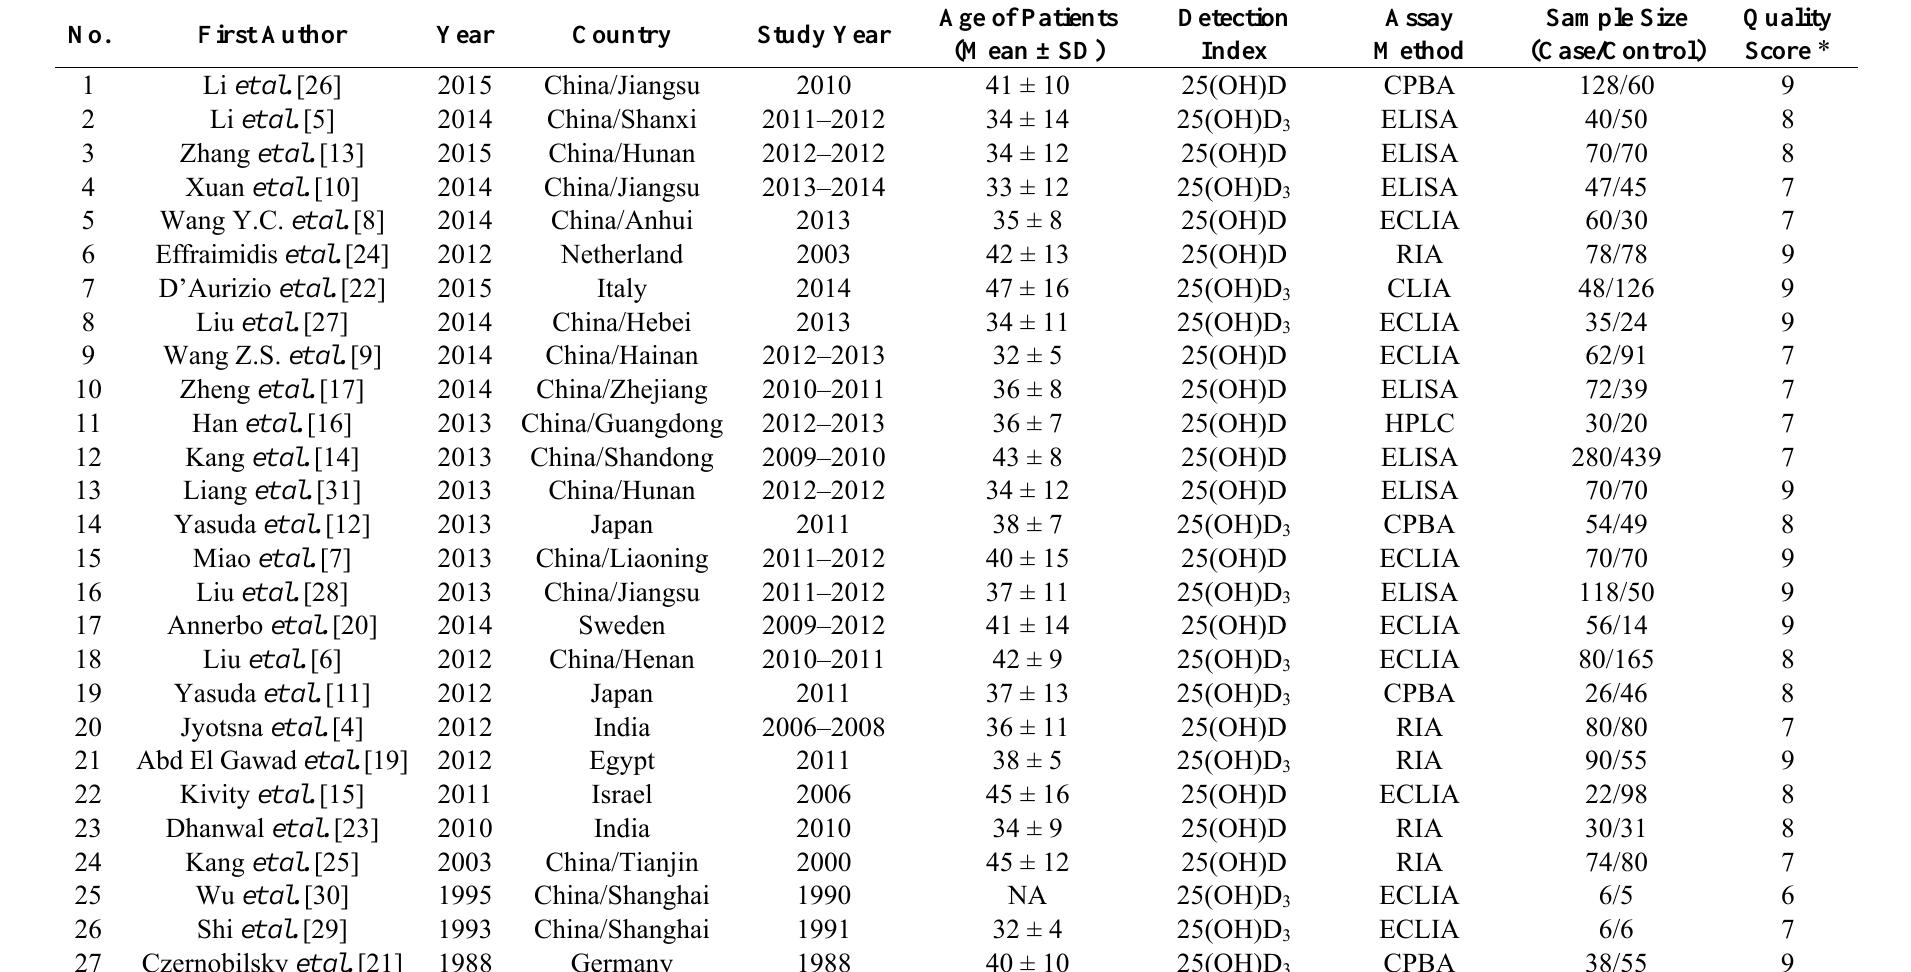
Table1. The characteristics of the included studies in the